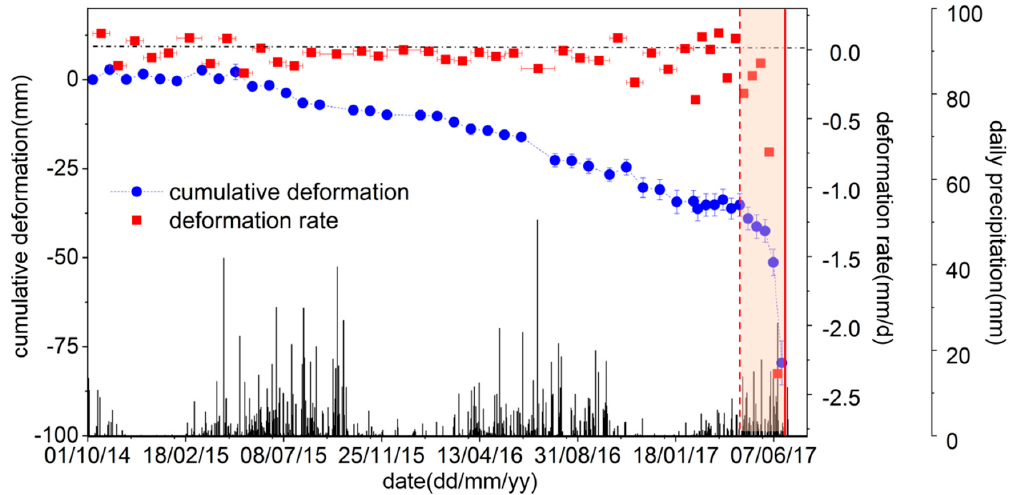
Figure 5. The time–series cumulative deformation in the line of sight (LOS) direction in the S1 region and precipitation in Xinmo village. The blue circles show the cumulative deformation, and the red squares show the deformation rate. The shaded orange region is the stage of acceleration, the red dash line represents the starting point of acceleration, and the red vertical line represents the time of collapse. The rainfall data (0.1-degree spatial resolution and one-day temporal resolution) was obtained by the Global Precipitation Measurement (GPM) (downloaded from: https://pmm.nasa.gov/data-access/downloads/gpm [30]).